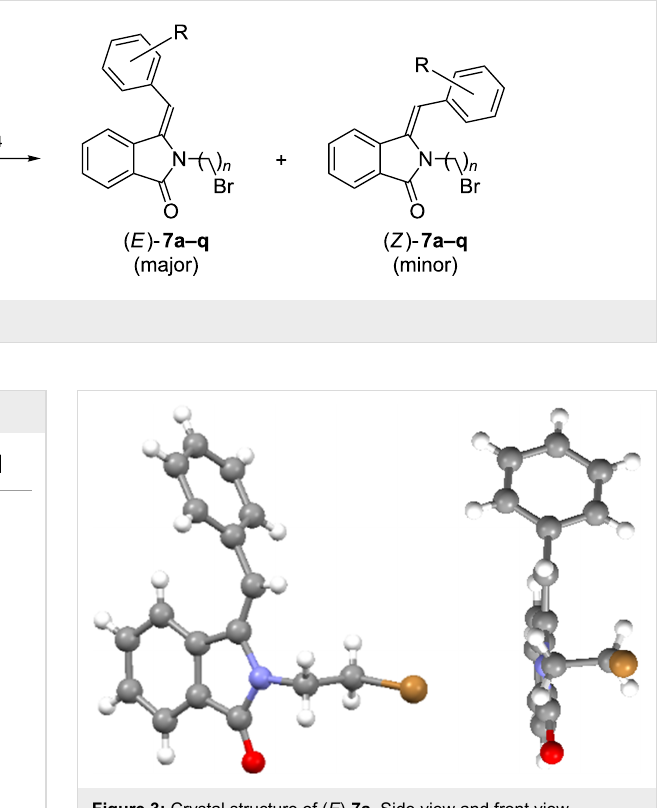
Figure 3: Crystal structure of ( E ) -7a . Side view and front